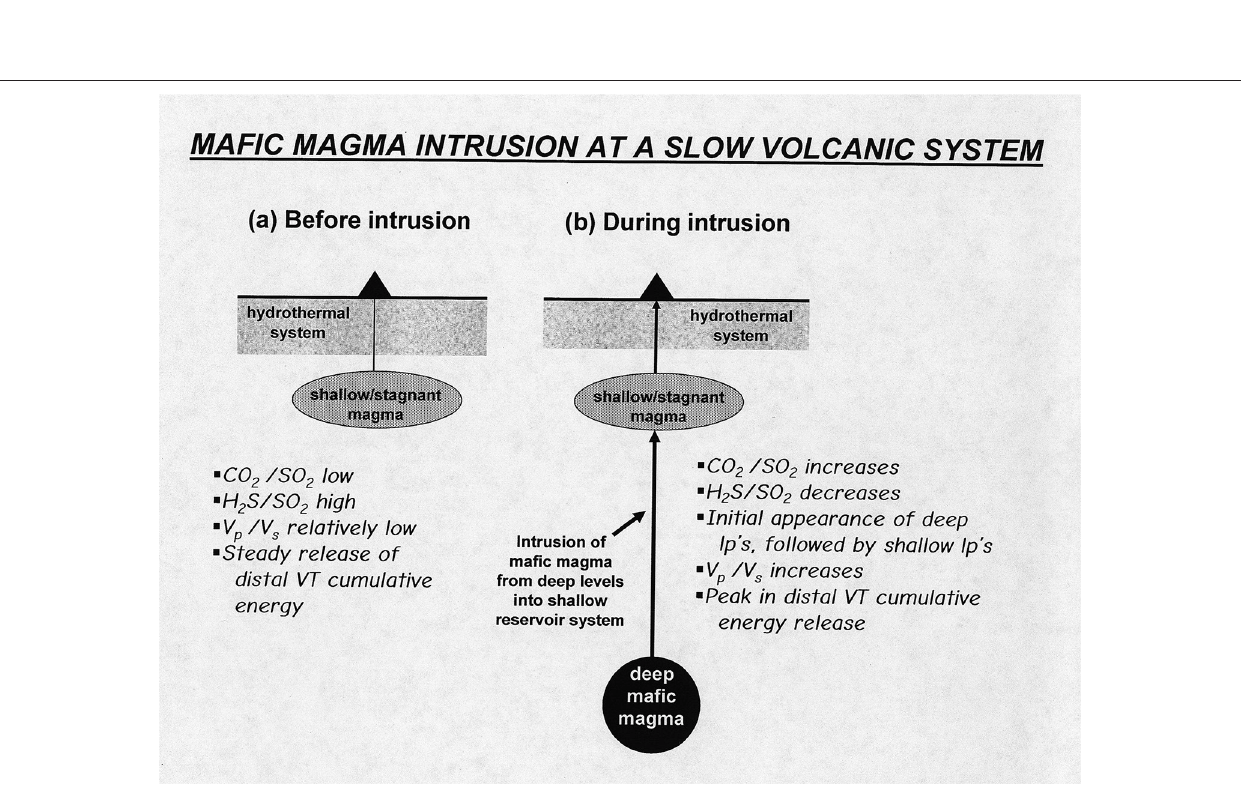
Frontiers in Earth Science |